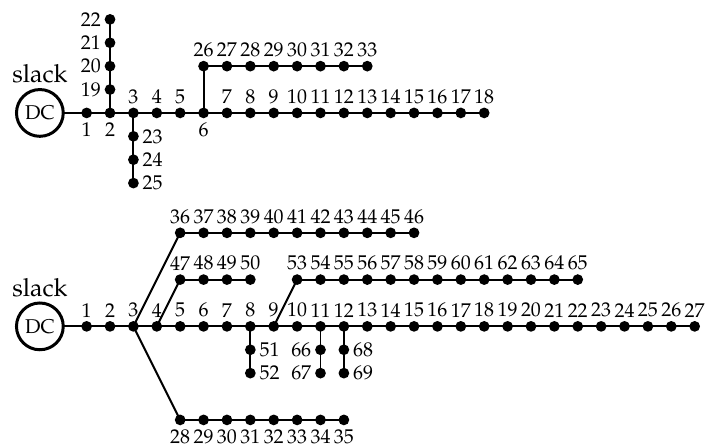
Figure 2. Electrical schematic of the test feeders: ( a ) 33-bus and ( b ) 69-bus.